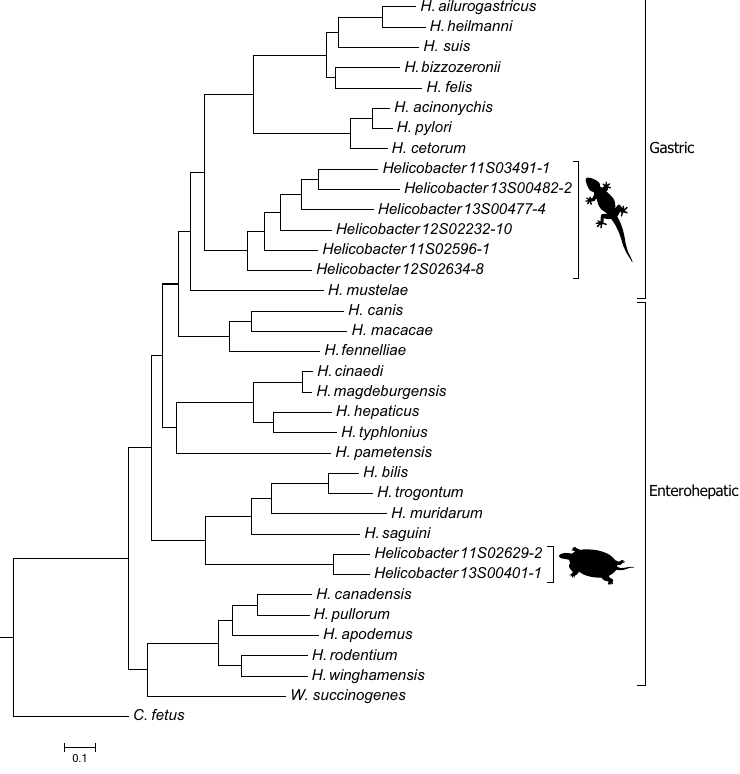
Figure 1. Rooted whole genome-based phylogeny for all Helicobacter strains used in this study. The squamate- and chelonian-associated Helicobacter clades are indicated with a lizard or chelonian, respectively. C . fetus strain 82–40 was used as outgroup and